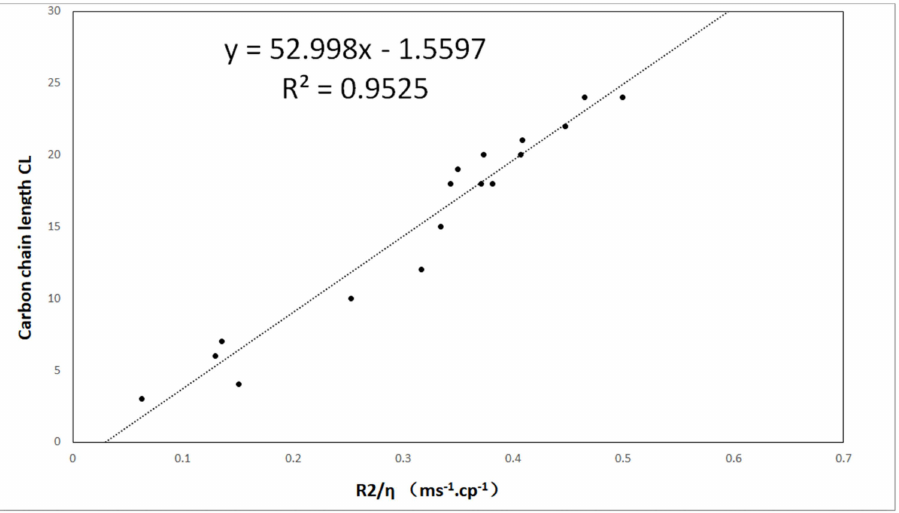
Figure 4. The carbon chain length CL is plotted as a function of R 2 / η . The dotted line is fitted by the linear model.